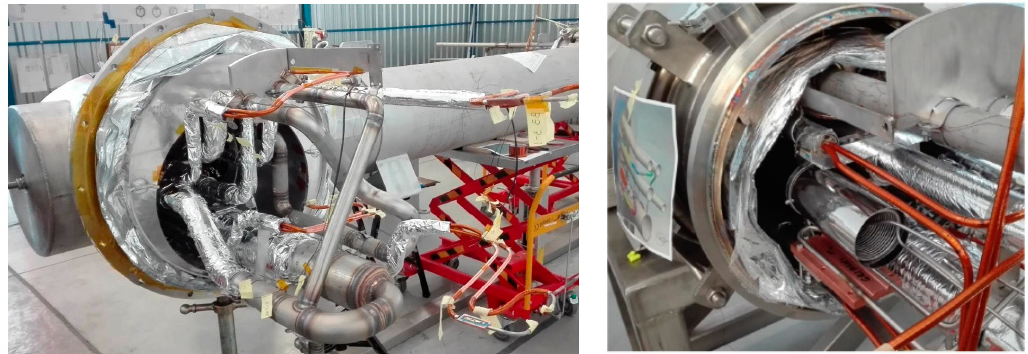
Figure 15. Preparation of the first BPL module for testing at GSI, Darmstadt.